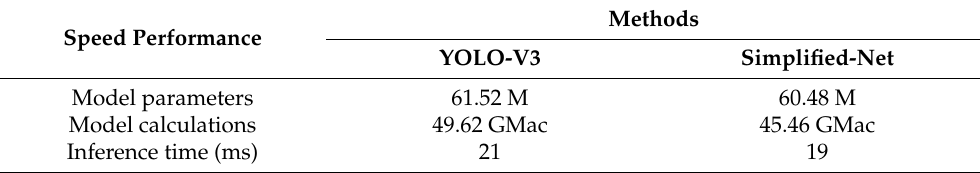
Table 5. Model parameters, calculations, and inference time of YOLO-V3 and